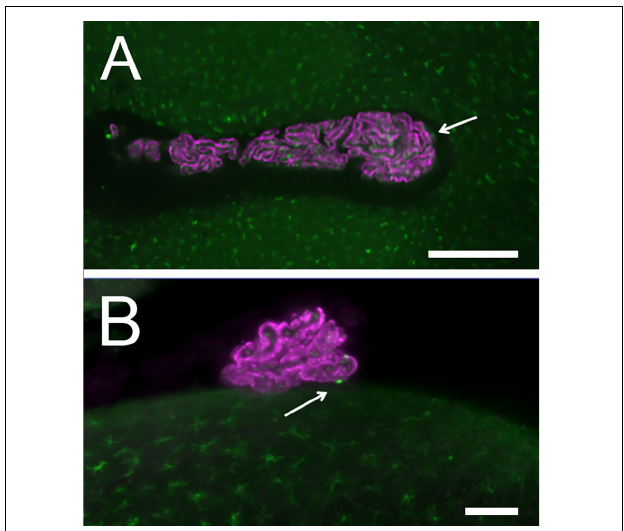
FIGURE 5 | CP macrophage distribution: Epithelium is labeled with Notch2, macrophages with Iba1. (A) LHS. Arrows point to epiplexus cells. Scale bar: 400 µ m. (B) RSS: an epiplexus cell is seen at the contact point with brainstem. Scale bar: 100 µ m.